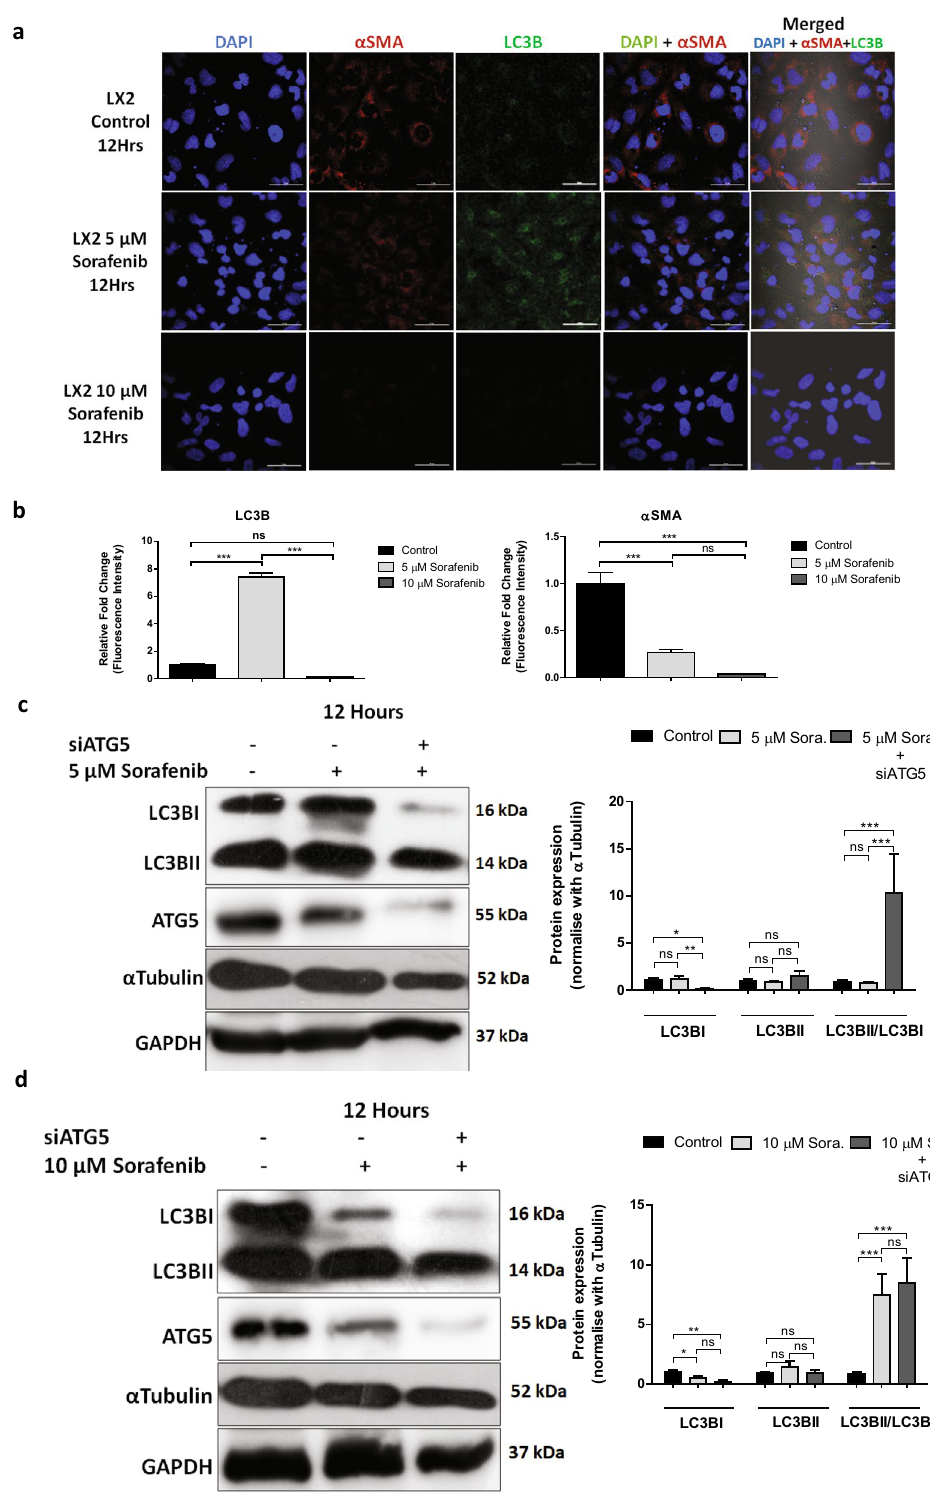
Figure 4. Dose dependent sorafenib induced LC3 signalling. ( a ) The confocal microscopic images showed alteration of LC3B expression in LX2 cells after exposure with low (5 µM) and high (10 µM) concentration of sorafenib for 12 h along with stellate cells activation marker α-SMA. Nuclei were stained with DAPI. Merged pictures showing co-expression of LC3B and α-SMA to evaluate autophagic regulation in activated stellate cells after sorafenib exposure. Images were taken using × 40 objective, scale bar: 50 μm. ( b ) Fluorescence intensity of LC3B and α-SMA quantified and represented as relative fold change with respective to untreated control. The bars represent mean ± s.d. from three independent experiments. ( c , d ) Western blot analysis showing protein expression of LC3B conversion in 5 µM and 10 µM sorafenib treated LX2 cells for 12 h. As a negative control the LC3B conversion were also assessed after transfection with 100 nM siRNA against ATG5. Protein level of ATG5 in ATG5 siRNA transfected LX2 cells were shown. Protein expression were quantified using ImageJ software. αTubulin and GAPDH were used as loading controls. Data represent mean ± s.d. from three independent experiments (ns > 0.05, *P < 0.05, **P < 0.01, ***P < 0.001 two-way analysis of